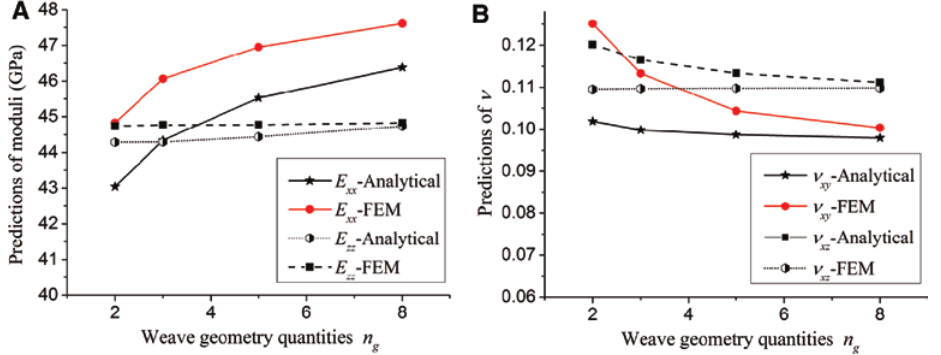
Figure 19: Effect of weave type on predicted values.